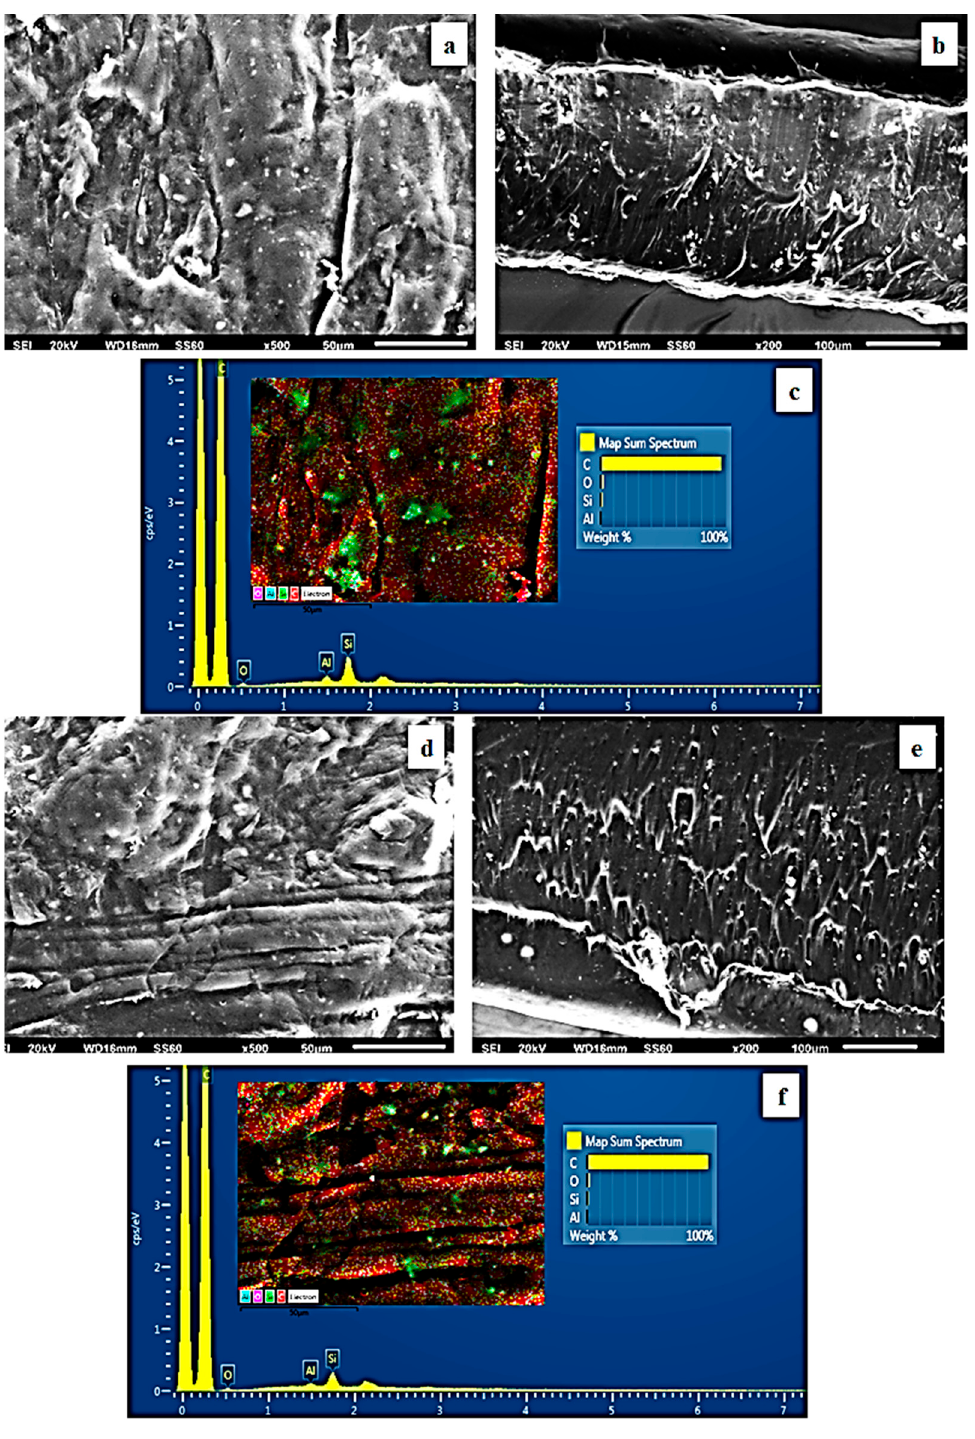
Figure 5. ( a,d ) SEM images of the surface and ( b , e ) cross-section of the nanocomposite films of LDPE/5NZ ( a , b ) and LDPE/5TO@NZ ( d , e ), respectively. ( c , f ) Energy-dispersive spectrometer (EDS) spectra, relative elemental analysis, and mapping of the surface from the SEM images at ×1000 magnification.